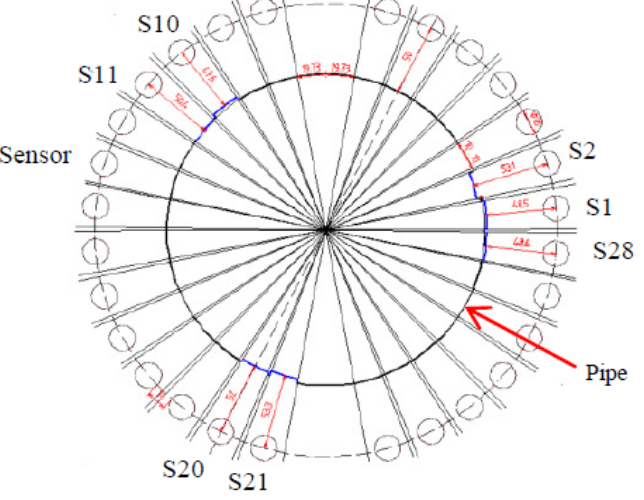
Figure 43. The reconstructed image of the cross-section of the pipeline segment at the location of the sensing ring. Reprinted under Creative Commons CC BY-NC-ND license